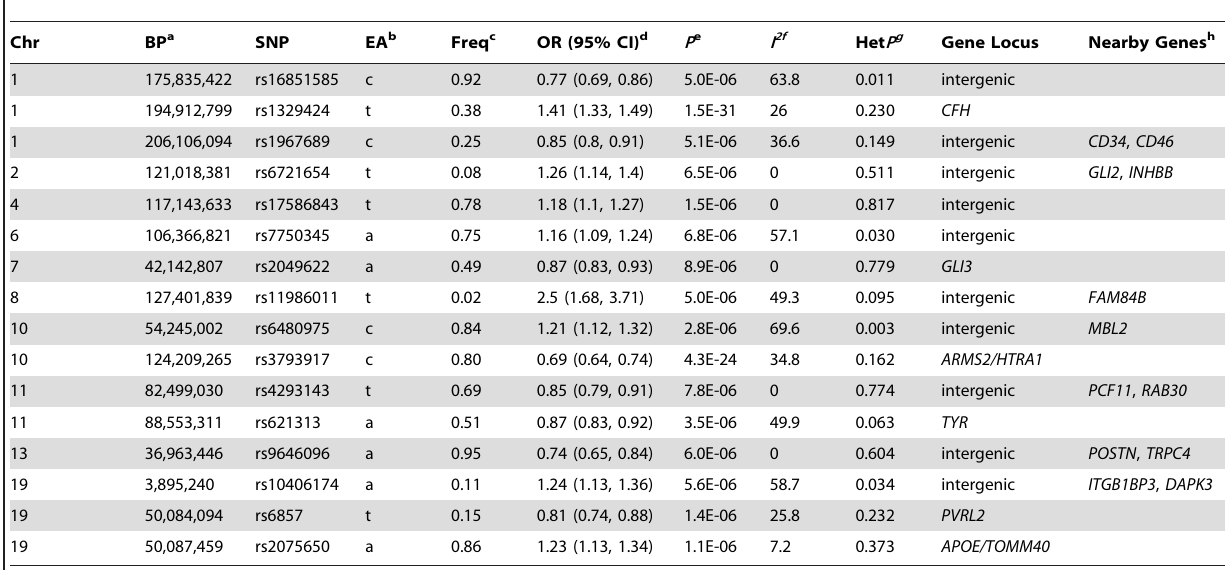
Table 2. Results for SNPs showing suggestive evidence of association ( P , 1 6 10 2 5 ) in the primary (European-ancestry) meta- analysis of early